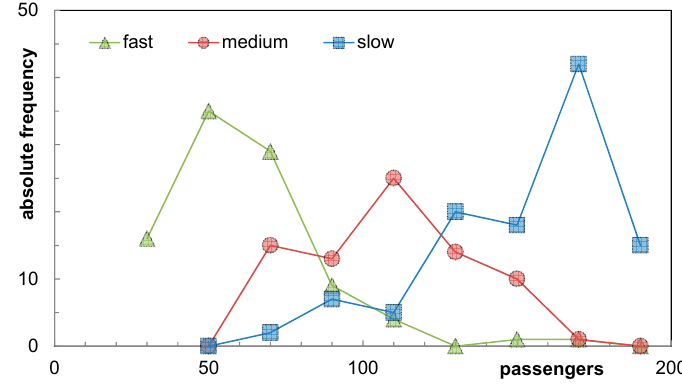
Figure 5. Boarding time classification of field measurements: fast, medium, and slow progress.